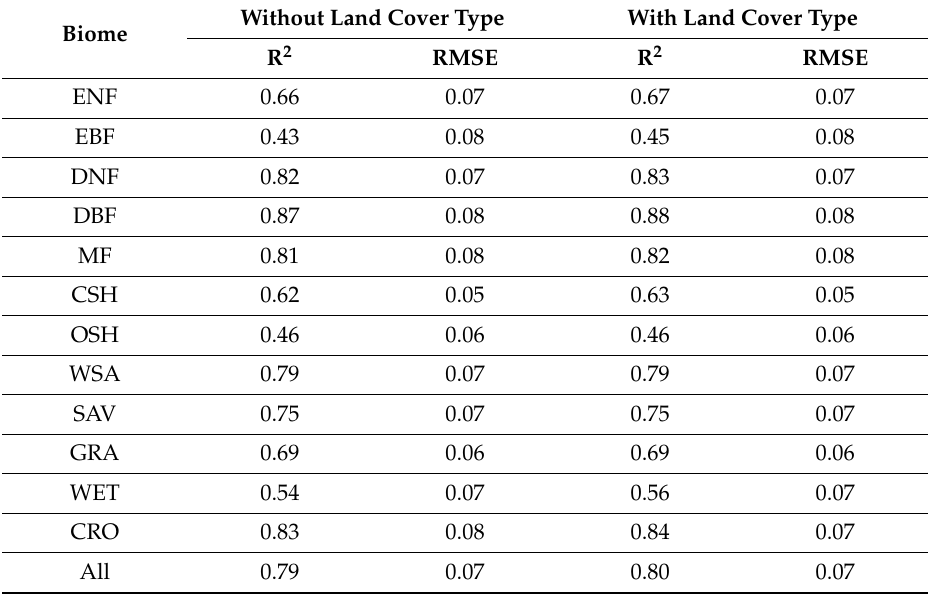
Figure 4. The validation of the predictive SIF model: Scatterplot of observed OCO-2 SIF versus predicted SIF in 2017. The dashed line is the 1:1 line, and the solid line is the regression line. Table 2. Validation of the predictive SIF model for each biome: Evergreen needleleaf forests (ENF), evergreen broadleaf forests (EBF), deciduous needleleaf forests (DNF), deciduous broadleaf forests (DBF), mixed forests (MF), closed shrublands (CSH), open shrublands (OSH), woody savannas (WSA), savannas (SAV), grasslands (GRA), croplands (CRO), and wetlands (WET). The units of the RMSE are W m − 2 μ m − 1 sr − 1 .